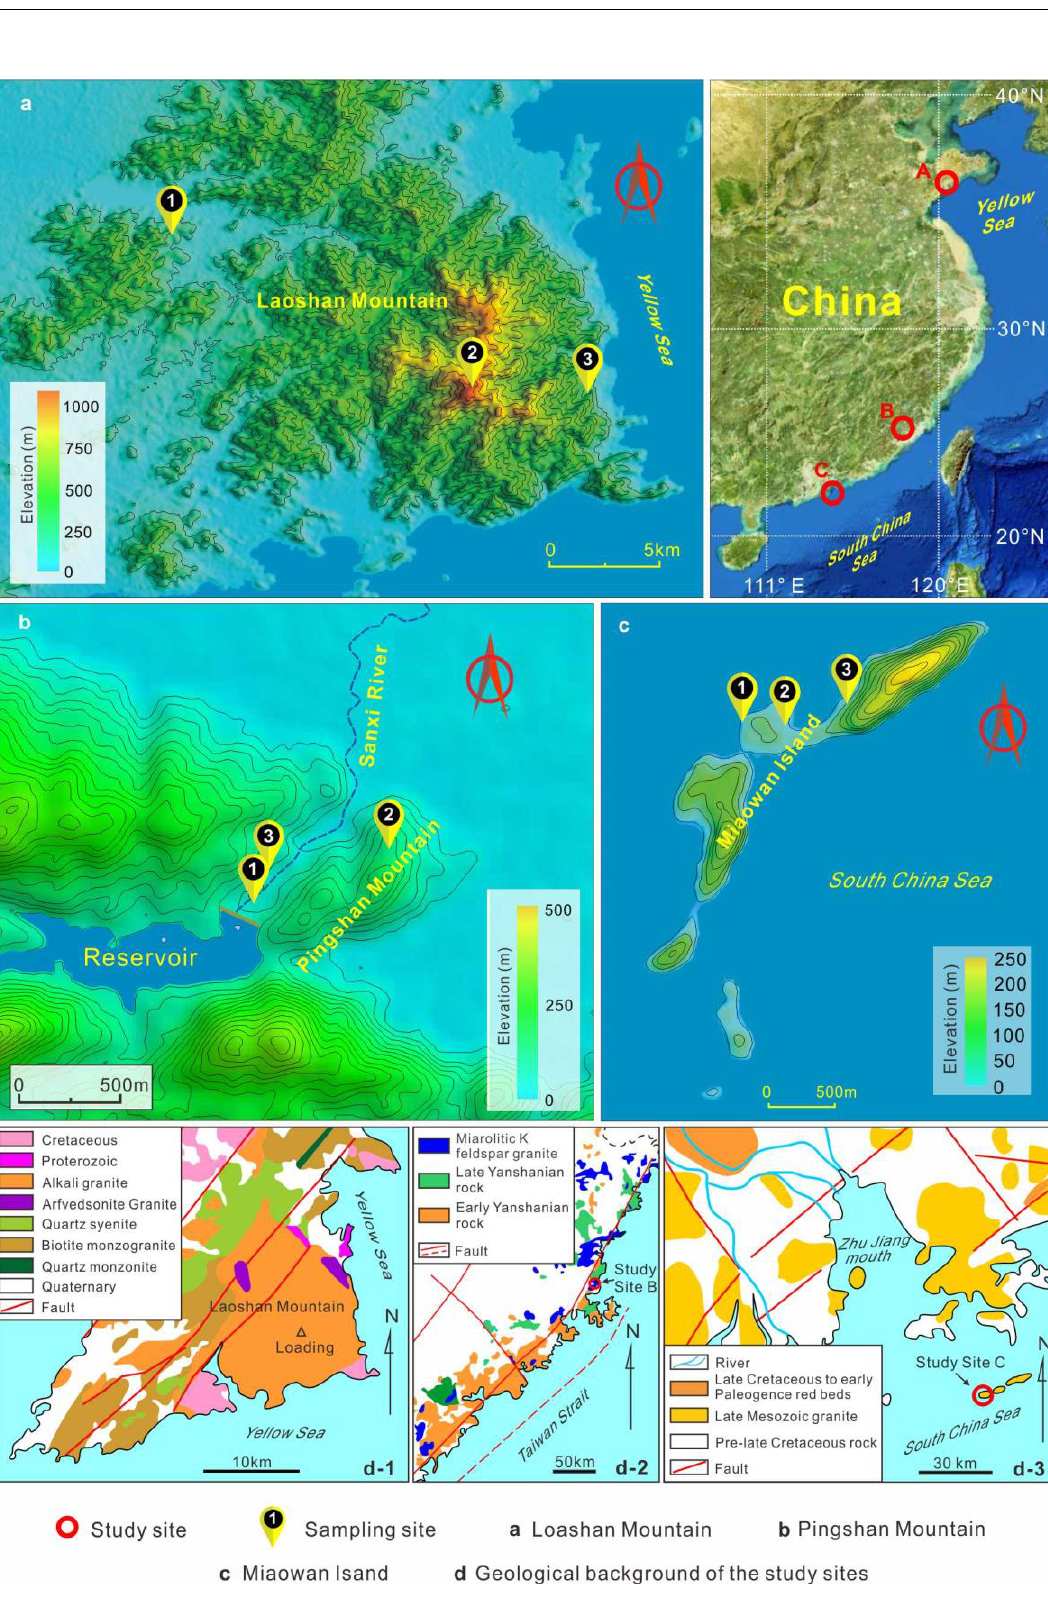
Figure 1. Maps showing study sites, sampling locations and geological settings of the study sites. ( a ) Laoshan Mountain, ( b ) Pingshan Mountain and the Sanxi River valley, ( c ) Miaowan Island and ( d ) geological sketch maps of the 3 study sites: ( d-1 ) Laoshan Mountain, ( d-2 ) Pingshan Mountain, and ( d-3 ) Miaowan Island.